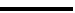
Figure 4: Chronological scheme of the various types of glass produced in antiquity. Modified from Wedepohl et al. (2011). Starting from the middle of the 1 st millennium BC, the Near East regions adopted another recipe for the production of glass in which the plant-ash was replaced with a mineral salt flux consisting of trona or natron 2 . These sodium carbonates are found in some evaporitic basins like those of the Wadi El Natrun valley in Egypt (Freestone et al., 2008). The natron glass had spread from the Near East to Europe and Asia where it becomes dominant until the 9 th century AD. Natron glass is generically called Roman glass even if found in contexts that precede or succeed the period of the Roman Empire (Freestone et al., 2008; Wedepohl et al., 2011; Gratuze, 2013). Since trona and natron are poor in potassium and magnesium, Roman glass can be distinguished from plant-ash glass by K O and MgO <1.5 wt% (Sayre & Smith, 1961). Most of the 2 Roman glass groups are chemically homogeneous throughout the Empire within some variability in major elements (Degryse, 2014), comparing to wood-ash glasses (Table